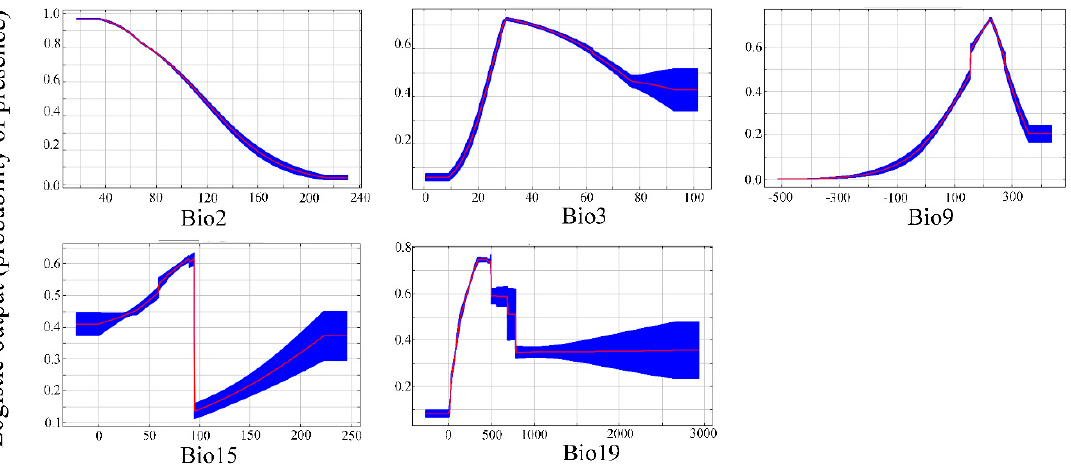
Figure 3. Response cures showing the relationships between the probability of presence of pest and five bioclimatic variables. Values shown are the average over 10 replicate runs; blue margins show ± SD calculated over 10 replicates.